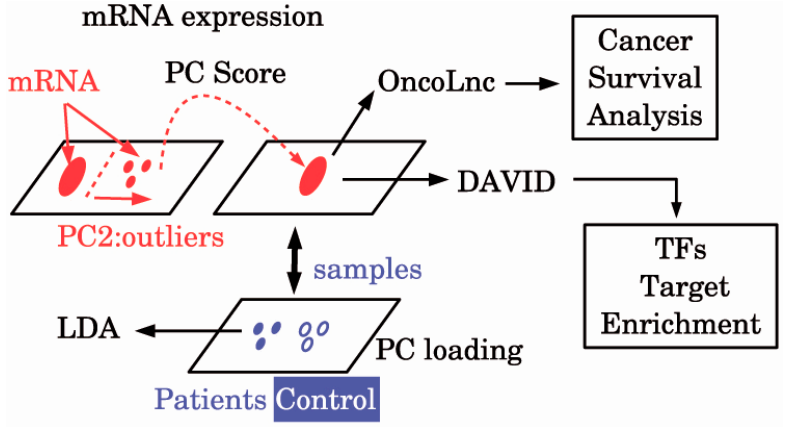
Figure 1. The diagram of the analysis. DAVID: Database for Annotation, Visualization, and Integrated Discovery; LDA: Linear discriminate analysis; mRNA: Messenger RNA; PC: Principal component; TFs: Transcription factors. Table 1. Confusion table of LDA between amyotrophic lateral sclerosis (ALS) and normal control.